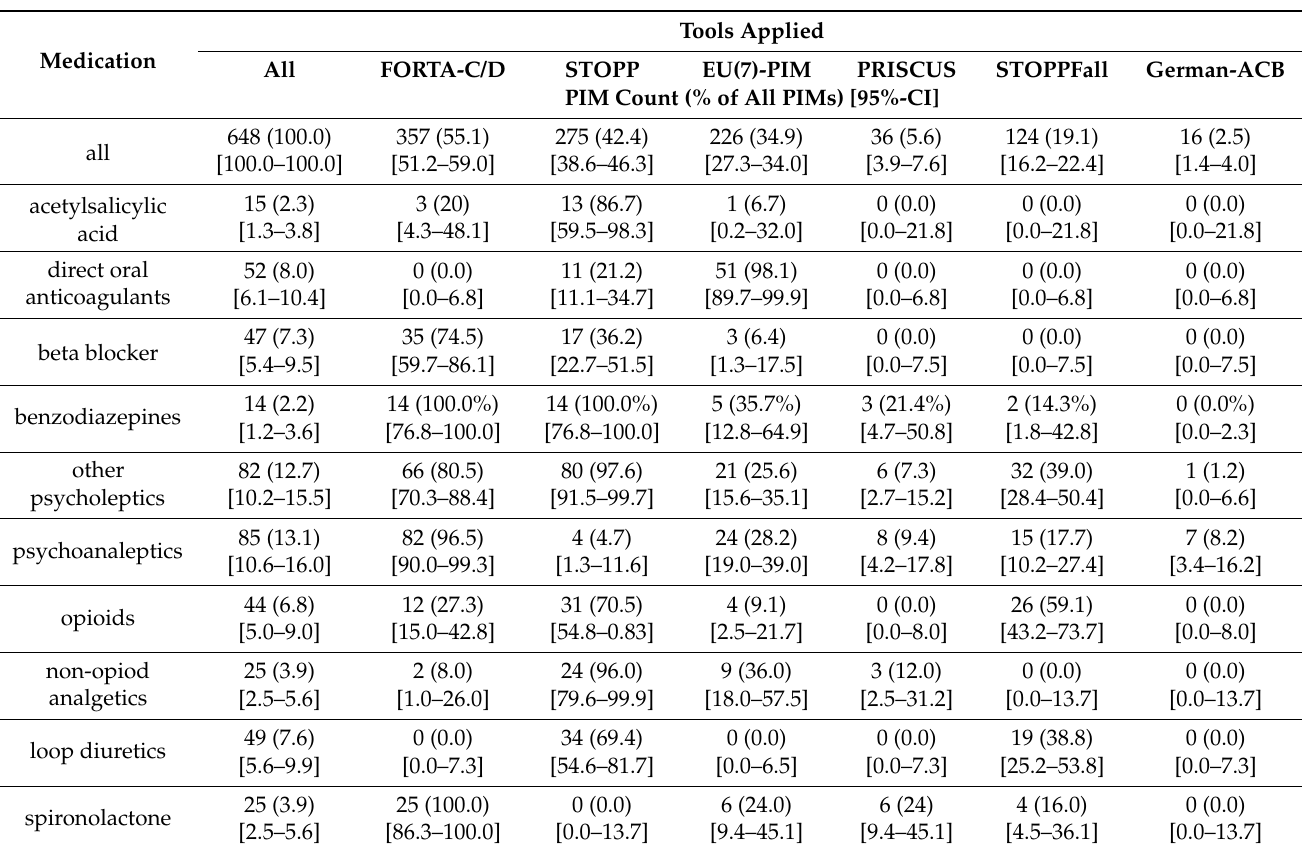
Table 5. Sensitivity of PIM detection for each tool and stratified by the most commonly implicated drugs (accounting for 67.6% of all PIMs detected by any tool).